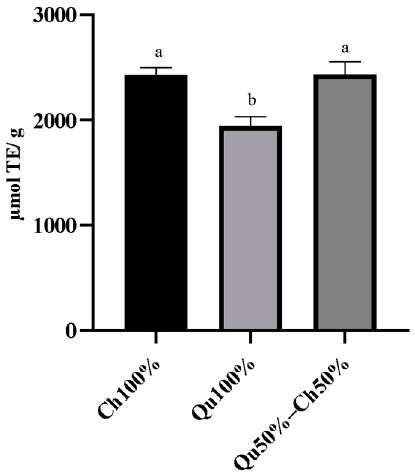
Figure 3. Antioxidant capacity of in vitro digested Ch100%, Qu100% and Qu50%–Ch50%. Data are presented as lsmeans ± SEM ( n = 3). The different superscript letters indicate a significant difference at p < 0.05 (one-way ANOVA). 2000 µM Trolox was included as an internal control.